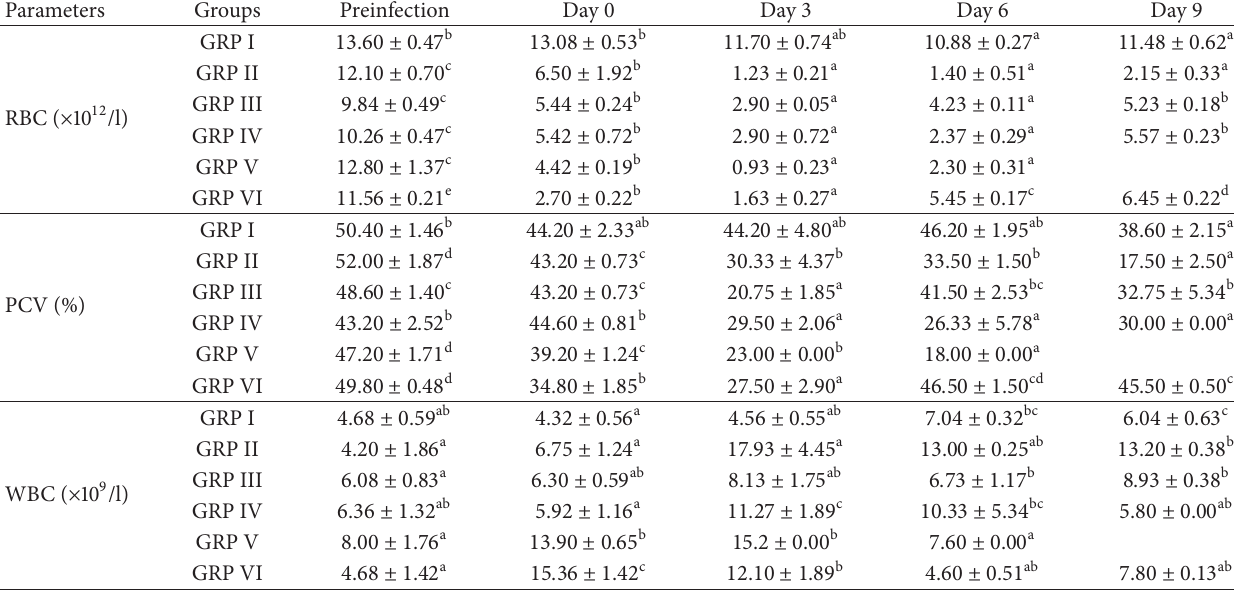
Table 1: The red blood cell and white blood cell count of mice infected with P. berghei and treated with aqueous leaf extracts of V. amygdalina , C. papaya, and halofantrine.